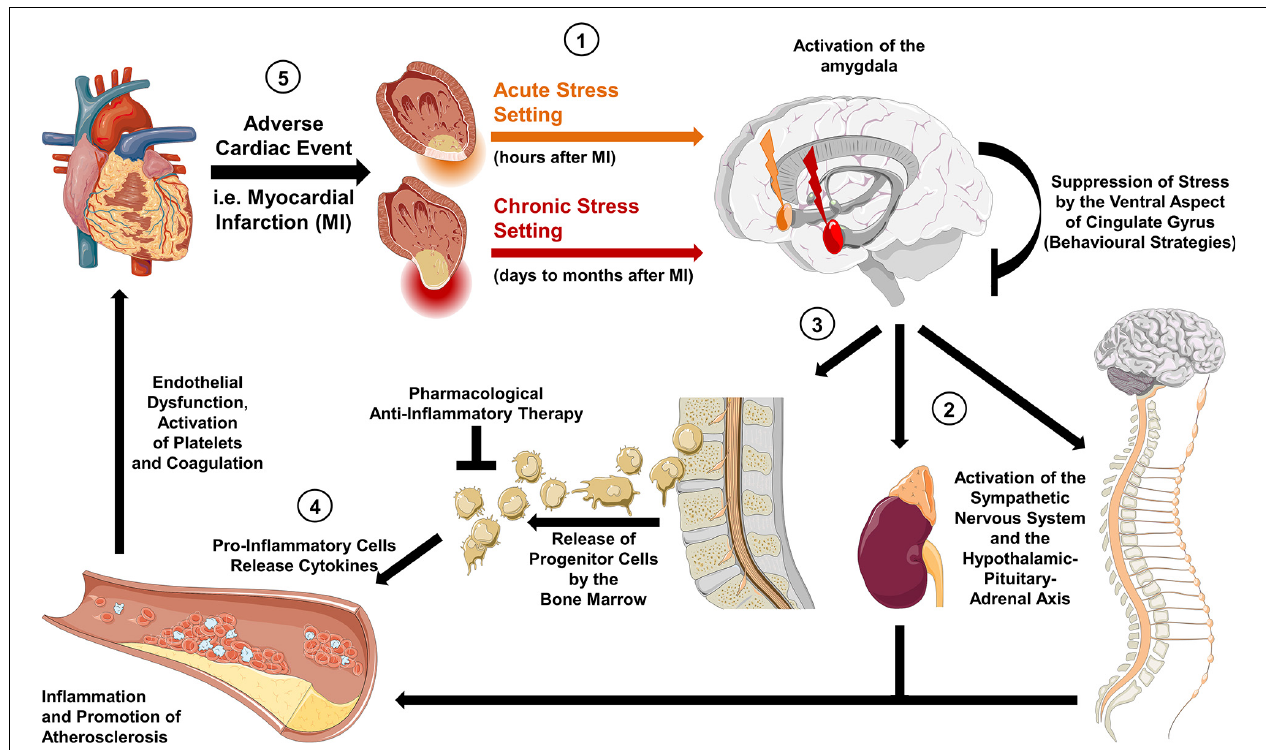
FIGURE 2 | Hypothetic mechanisms of the neuro-inflammatory-vascular circuit. (1) Activity in the brain’s salient network is induced by acute stress (orange arrow) and chronic stress (red arrow), thereby triggering the activation of the amygdala. (2) Efferent projections to the brainstem upregulate sympathetic activity as well as the hypothalamic-pituitary-adrenal axis leading to an increase in circulating norepinephrine and cortisol. In an acute setting this results in an increased heart rate and blood pressure, which can be pharmacologically targeted by sympatholytic agents. In a chronic state, the tonic firing of the amygdala leads to modulation of central brain structures, such as the locus coeruleus, and to a chronic inflammatory state. (3) This is reflected by enhanced bone marrow activity and release of progenitor inflammatory cells. (4) Inflammatory cytokines (interleukin-6 and interleukin-18) promote endothelial dysfunction and progression of atherosclerosis. (5) The latter increases the risk of adverse cardiac events. Targeted anti-inflammatory treatment or behavioral strategies (e.g., stress reduction concepts) have the potential to diminish detrimental effects on the cardiovascular system.